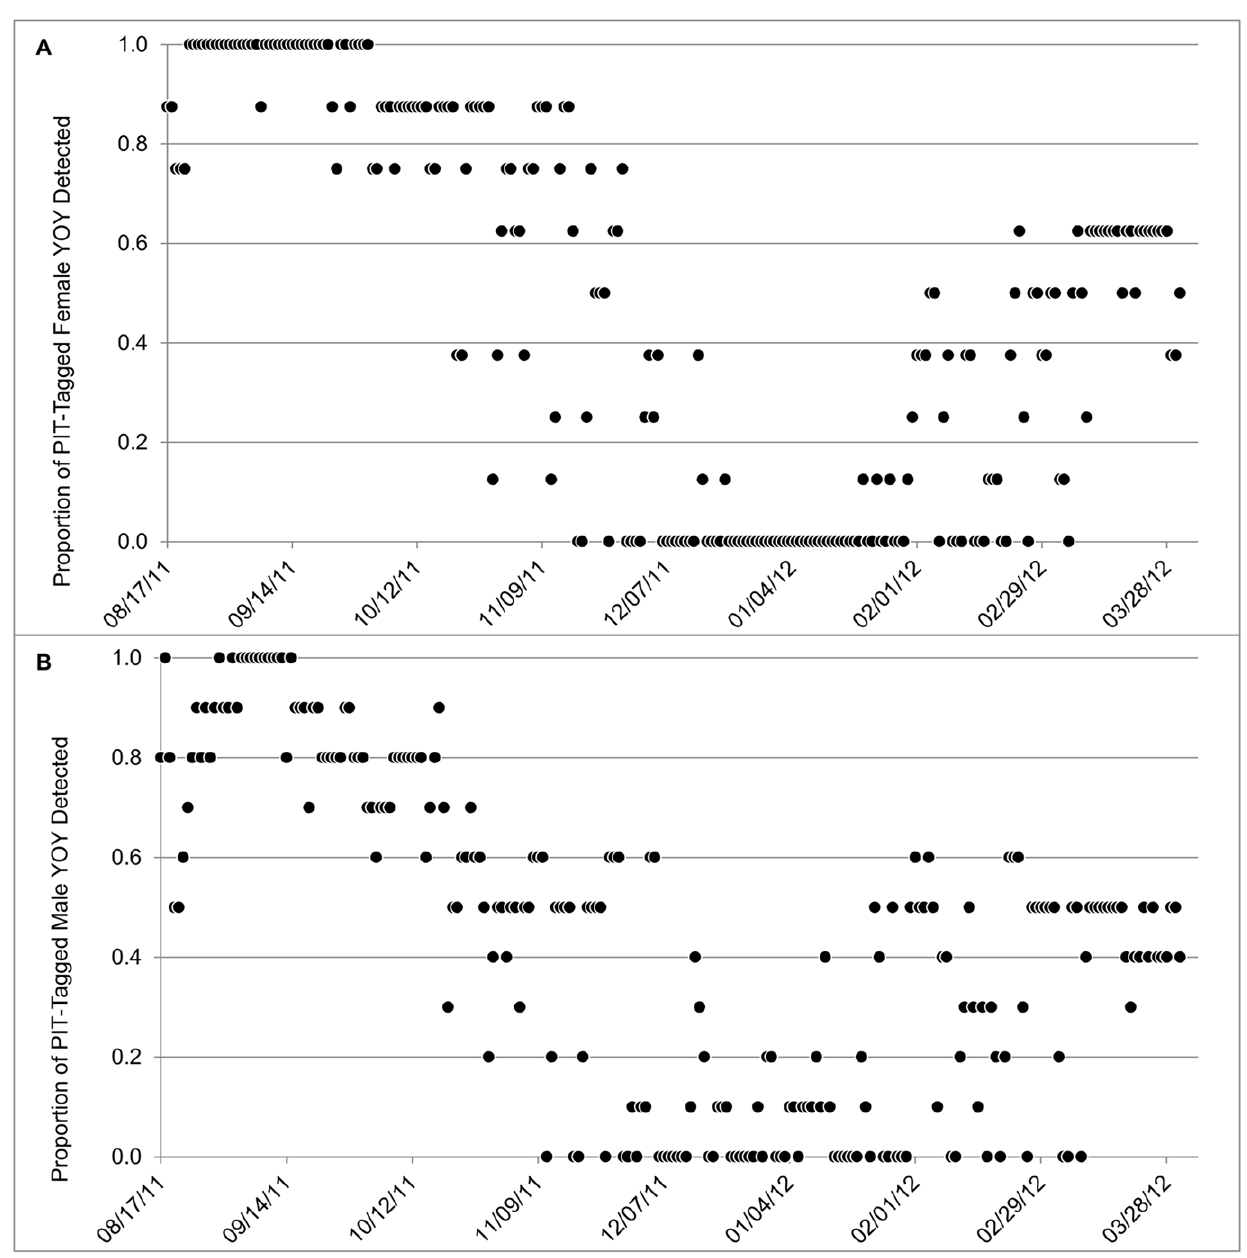
Figure 6. Daily activity of PIT-tagged female (A) and male (B) Rafinesque’s big-eared bat young-of-the-year at a man-made structure in Mammoth Cave National Park, Kentucky,